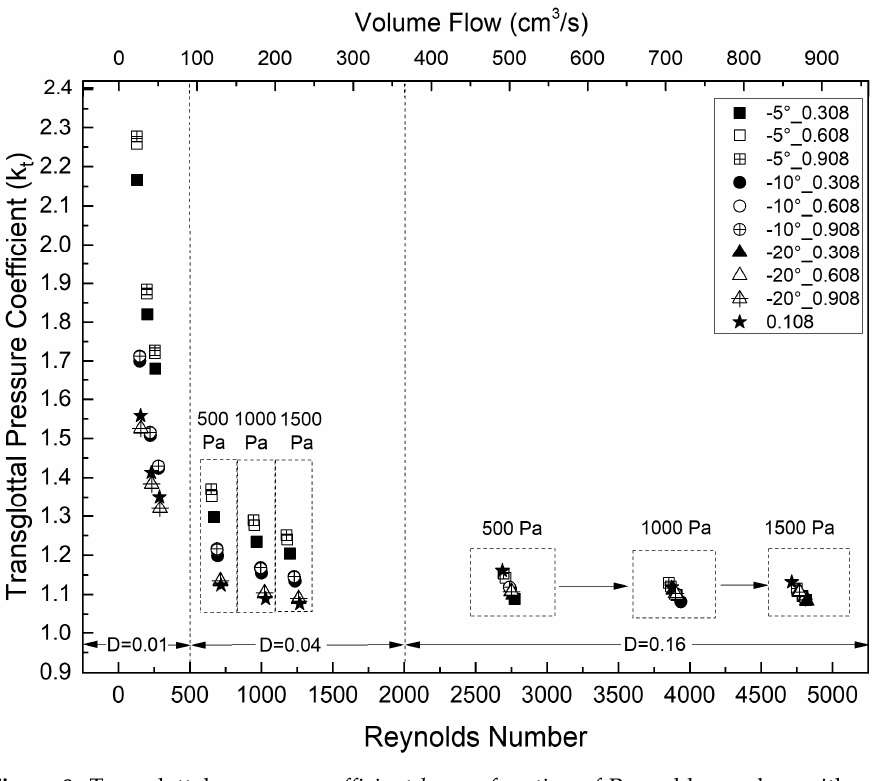
Figure 8. Transglottal pressure coefficient k t as a function of Reynolds number, with parameters of 0.108 cm, 0.308 cm, 0.608 cm, and 0.908 cm vertical glottal duct length, − 5°, − 10°, and − 20° convergent glottal angle, and 0.01 cm, 0.04 cm, and 0.16 cm glottal minimal diameter.